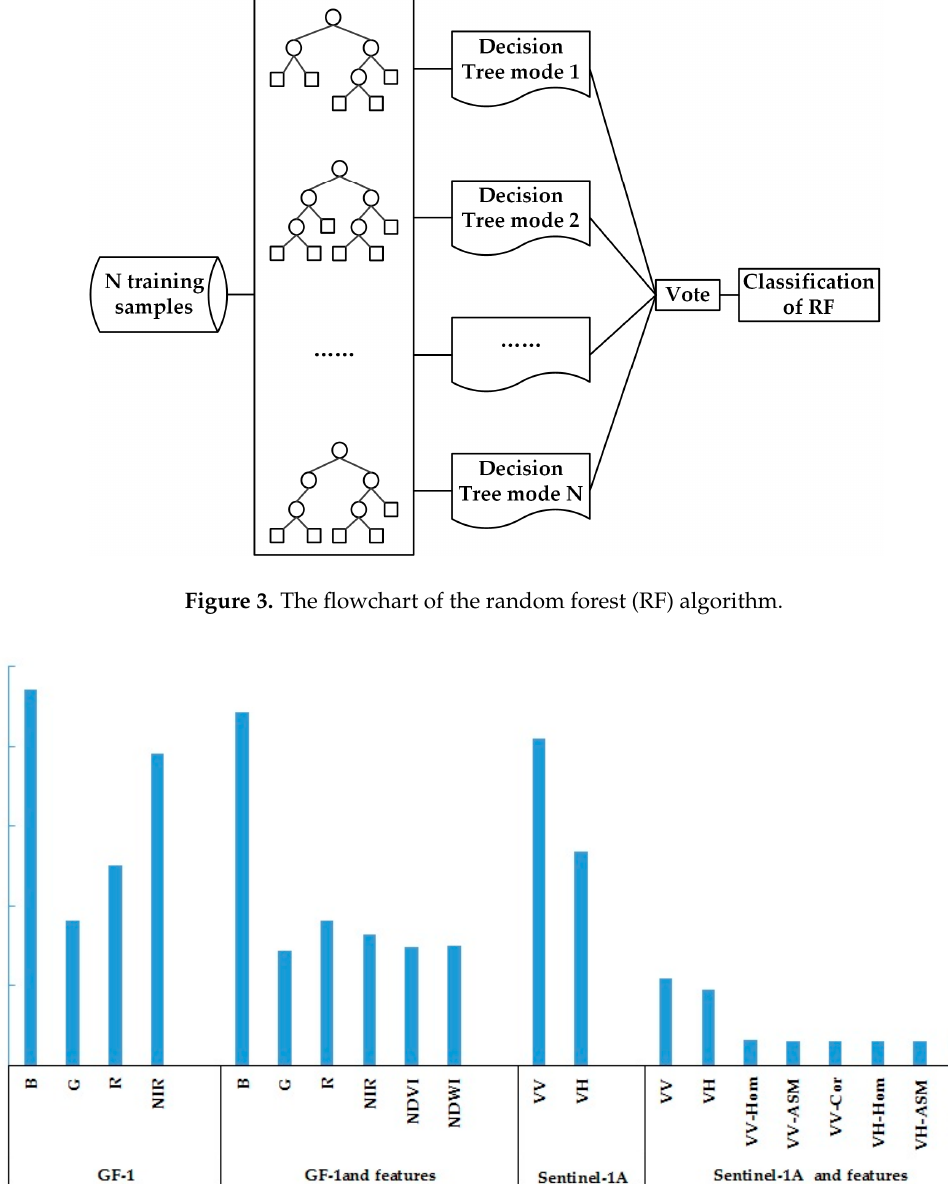
Figure 4. Feature importance.